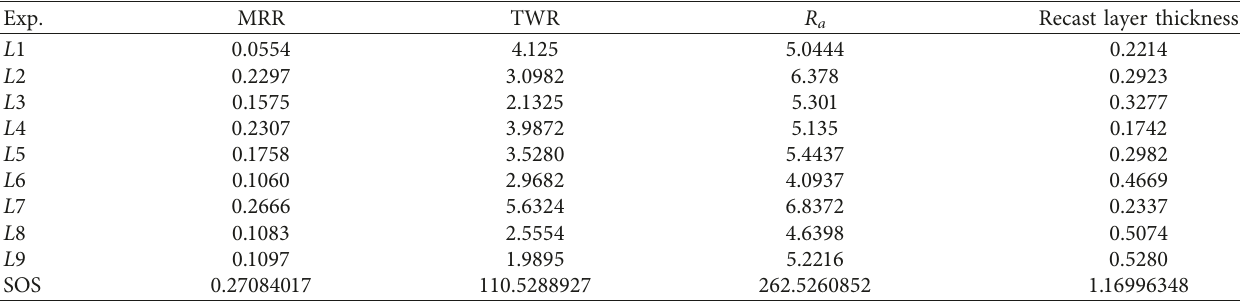
Table 4: Determination of performance matrix.